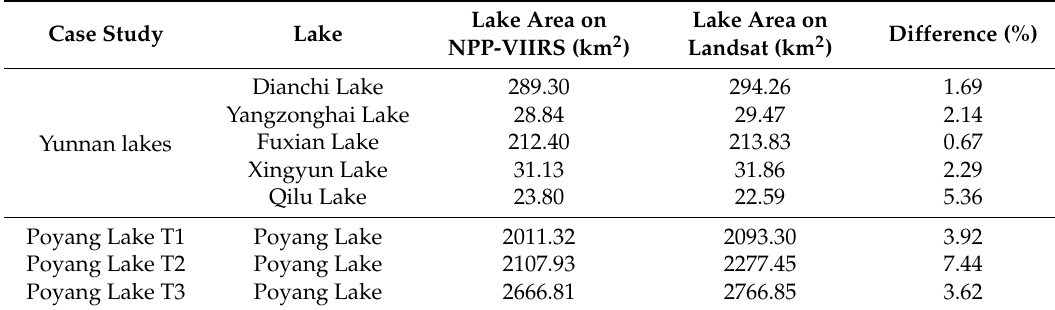
Table 3. Difference of lake areas * calculated from the NPP–VIIRS and